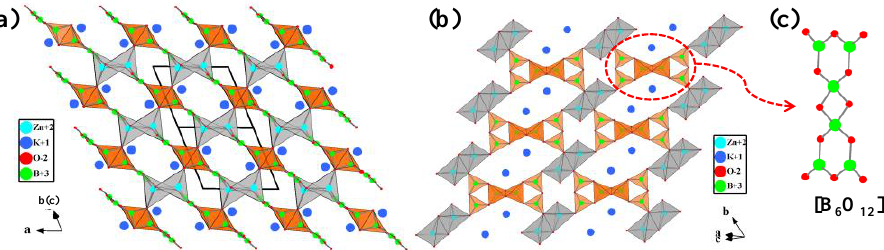
Figure 6. ( a ) The crystal structure of KZnB 3 O 6 viewed along the [01 1 ̅ ] direction; ( b ) Connection details of [B 6 O 12 ] 6 − and [Zn 2 O 6 ] 8 − blocks in the ( 1 ̅ 11) plane; (c) The [B 6 O 12 ] 6 − group. Adapted from Ref. [66,69], with permission of John Wiley and Sons.